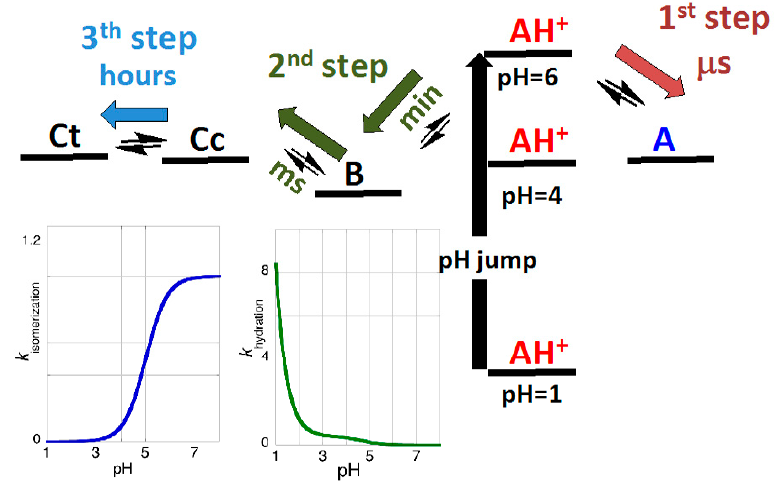
Scheme 10. Energy level diagram of a system possessing high cis-trans isomerization barrier. During the mixing time, an equilibrium between AH + and A is established. The second step (green) is controlled by the hydration reaction, and the third and slower (blue) by the isomerization.